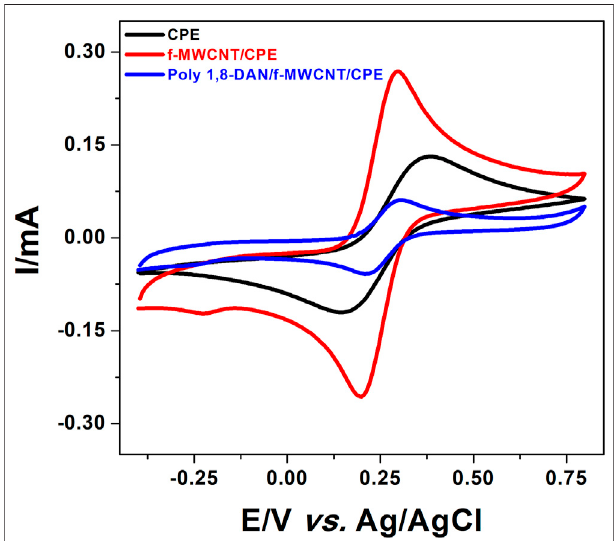
FIGURE 4 | CV of CPE (black line), f-MWCNT/CPE (red line), and poly 1,8-DAN/f-MWCNT/CPE (blue line) in 0.5 M of KCl containing 10 mM of [Fe(CN) 6 ] 3 − /4 − at a scan rate of 50 mV/s.